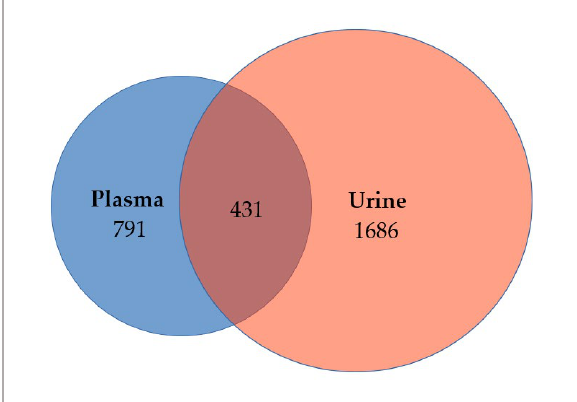
Figure 1. Venn diagram showing the number of somatic variants that could be detected in the ctDNA of both body fluids. Comparing all ctDNA variants of matching plasma and urine samples, 791 were exclusively found in plasma ctDNA, while 1686 variants were found in urinary ctDNA only. Interestingly, a total number of 431 were found in the ctDNA of both body fluids.